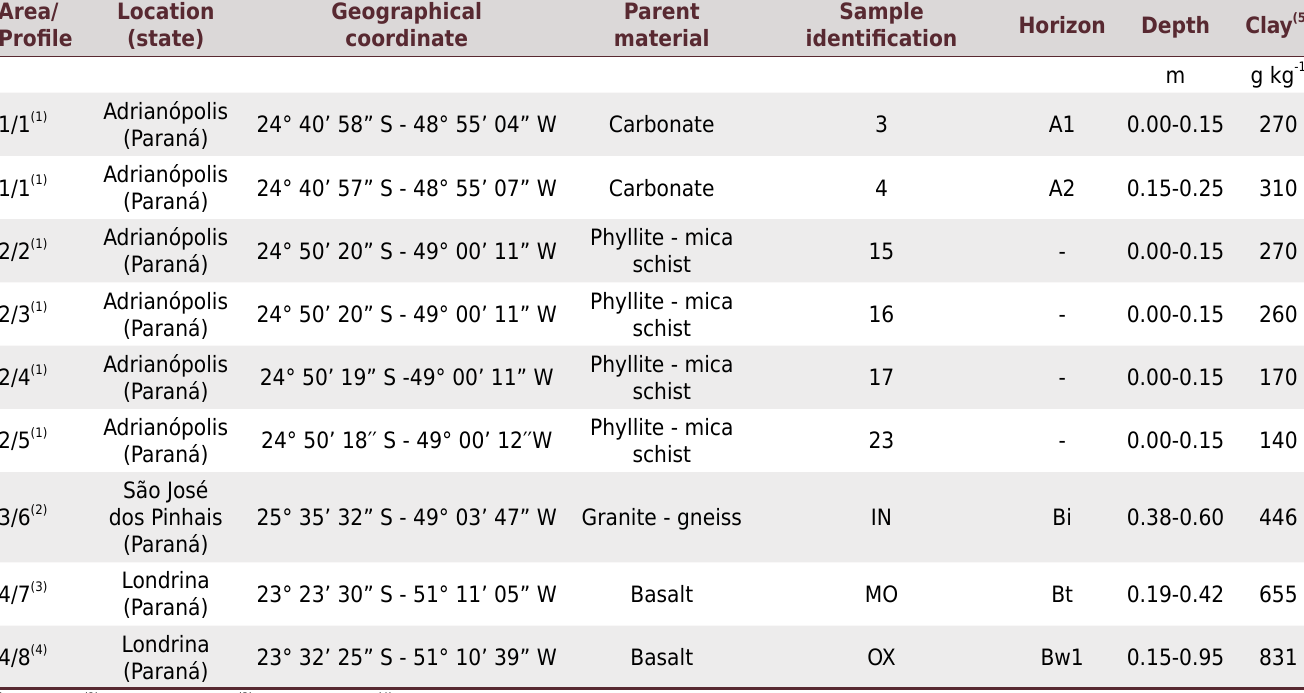
Table 1. General characteristics and clay content of the